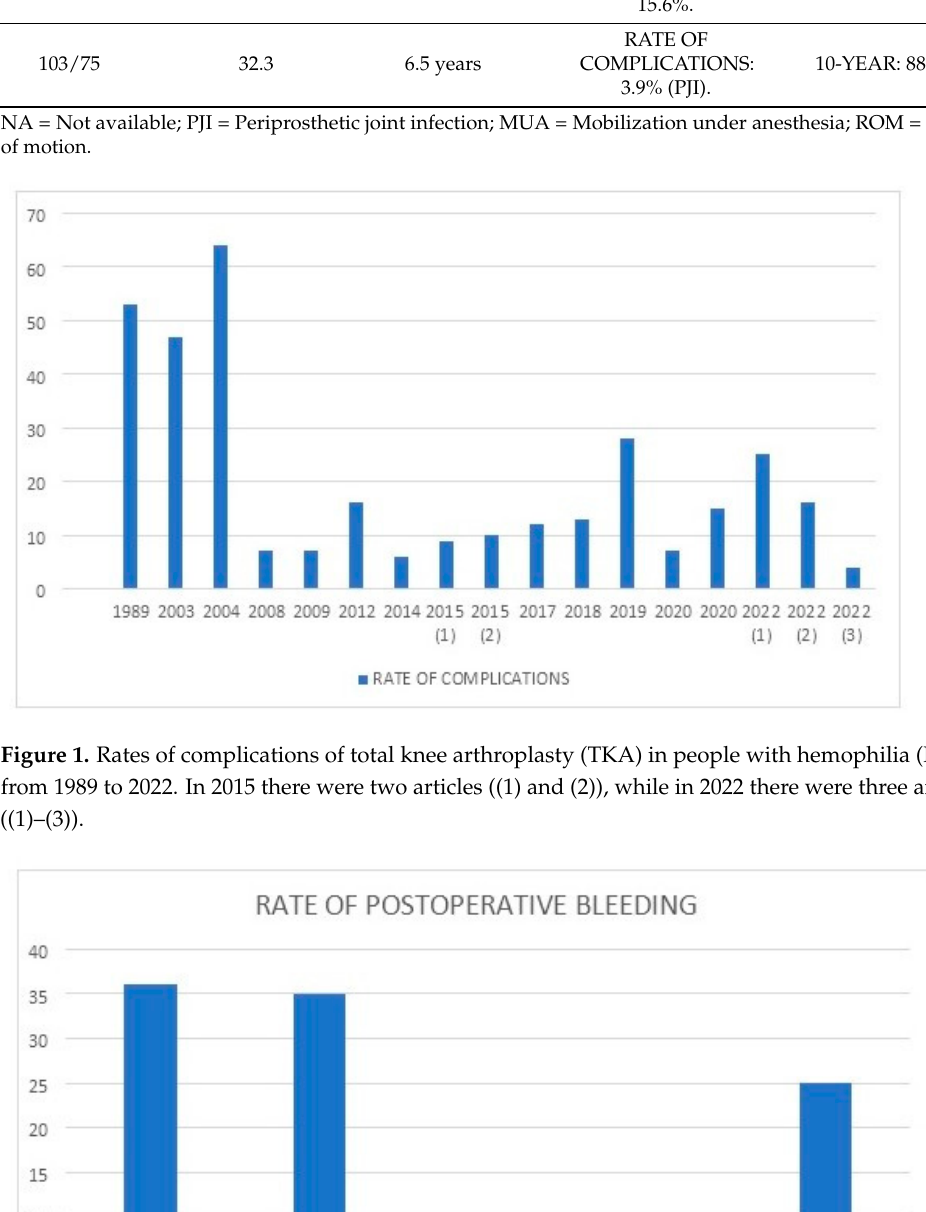
Figure 2. Rates of postoperative bleeding after total knee arthroplasty (TKA) in people with hemo- philia (PWH) from 1989 to 2022.